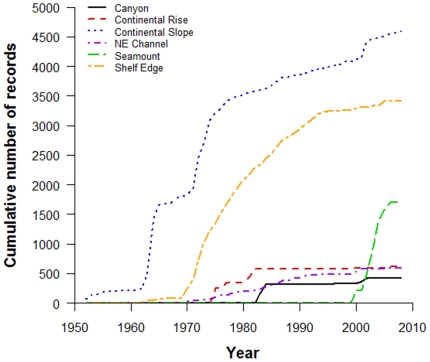
Cumulative number of species records in the deep-sea database within six sub-regions since 1950.